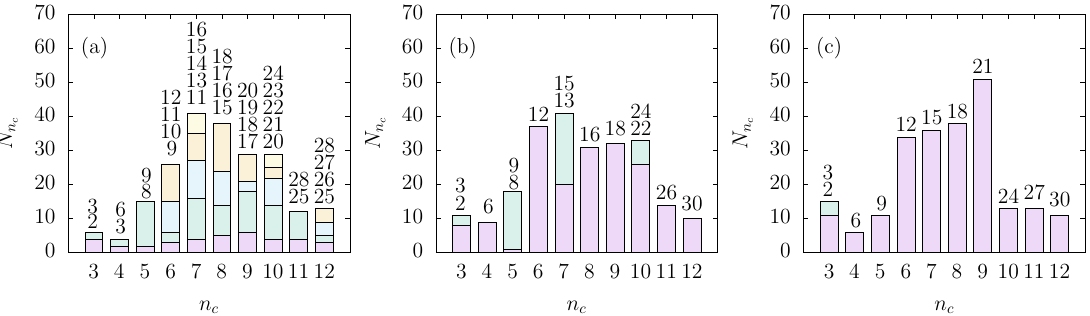
Figure 5. Distribution of the number of clusters N n ( a ) χ = 0.125; ( b ) χ = 0.25; and ( c ) χ = 0.5. Each differently colored bar is labeled, from top to bottom, with the bond number n b